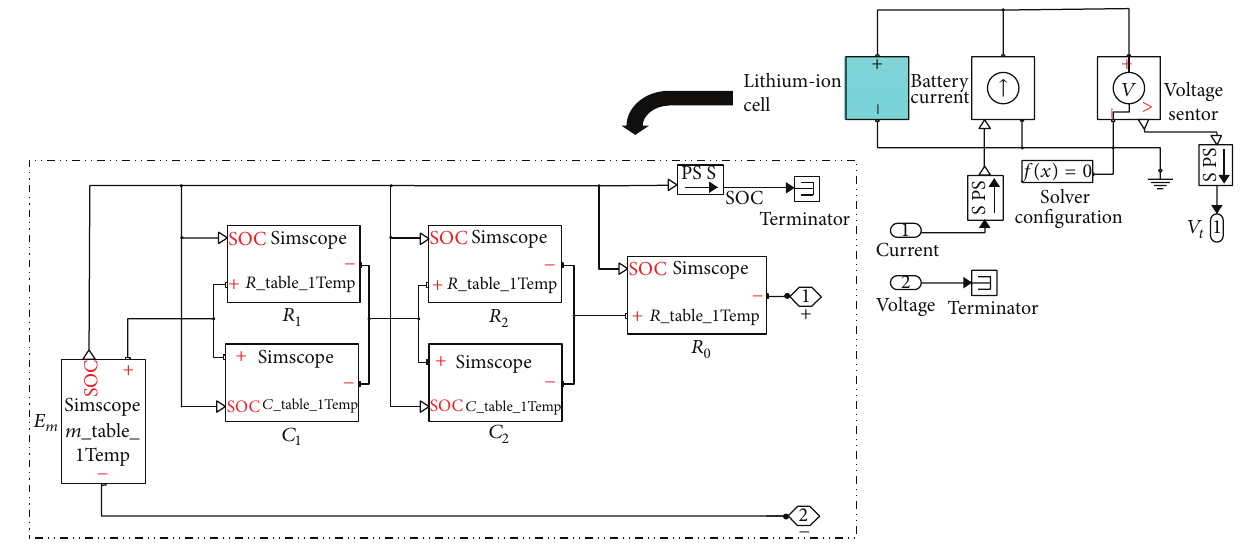
Figure 2: Second-order RC model in